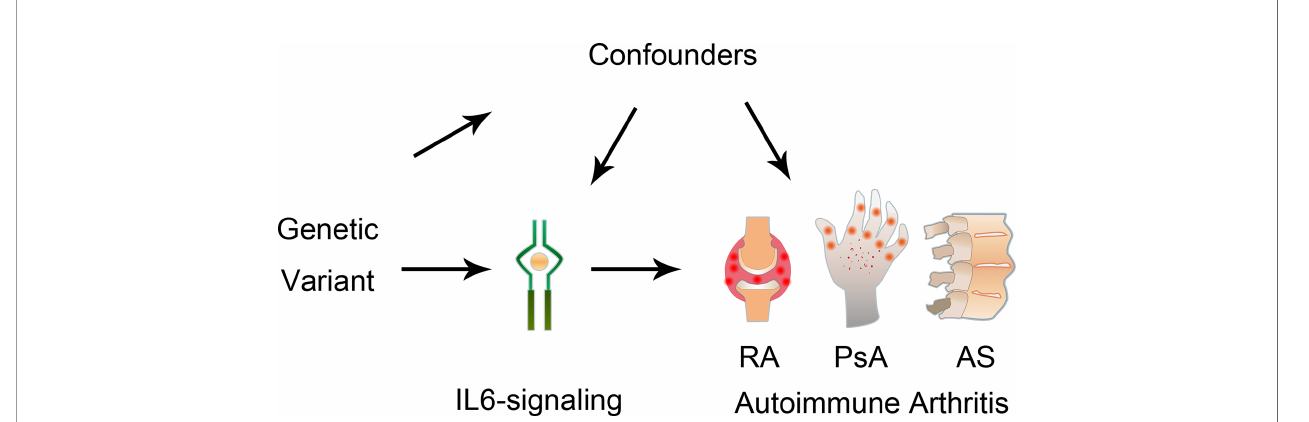
FIGURE 1 | Graphical diagram of the Mendelian randomization analysis between IL6 and risk of autoimmune arthritis. RA, rheumatoid arthritis; AS, ankylosing spondylitis; PsA, psoriatic